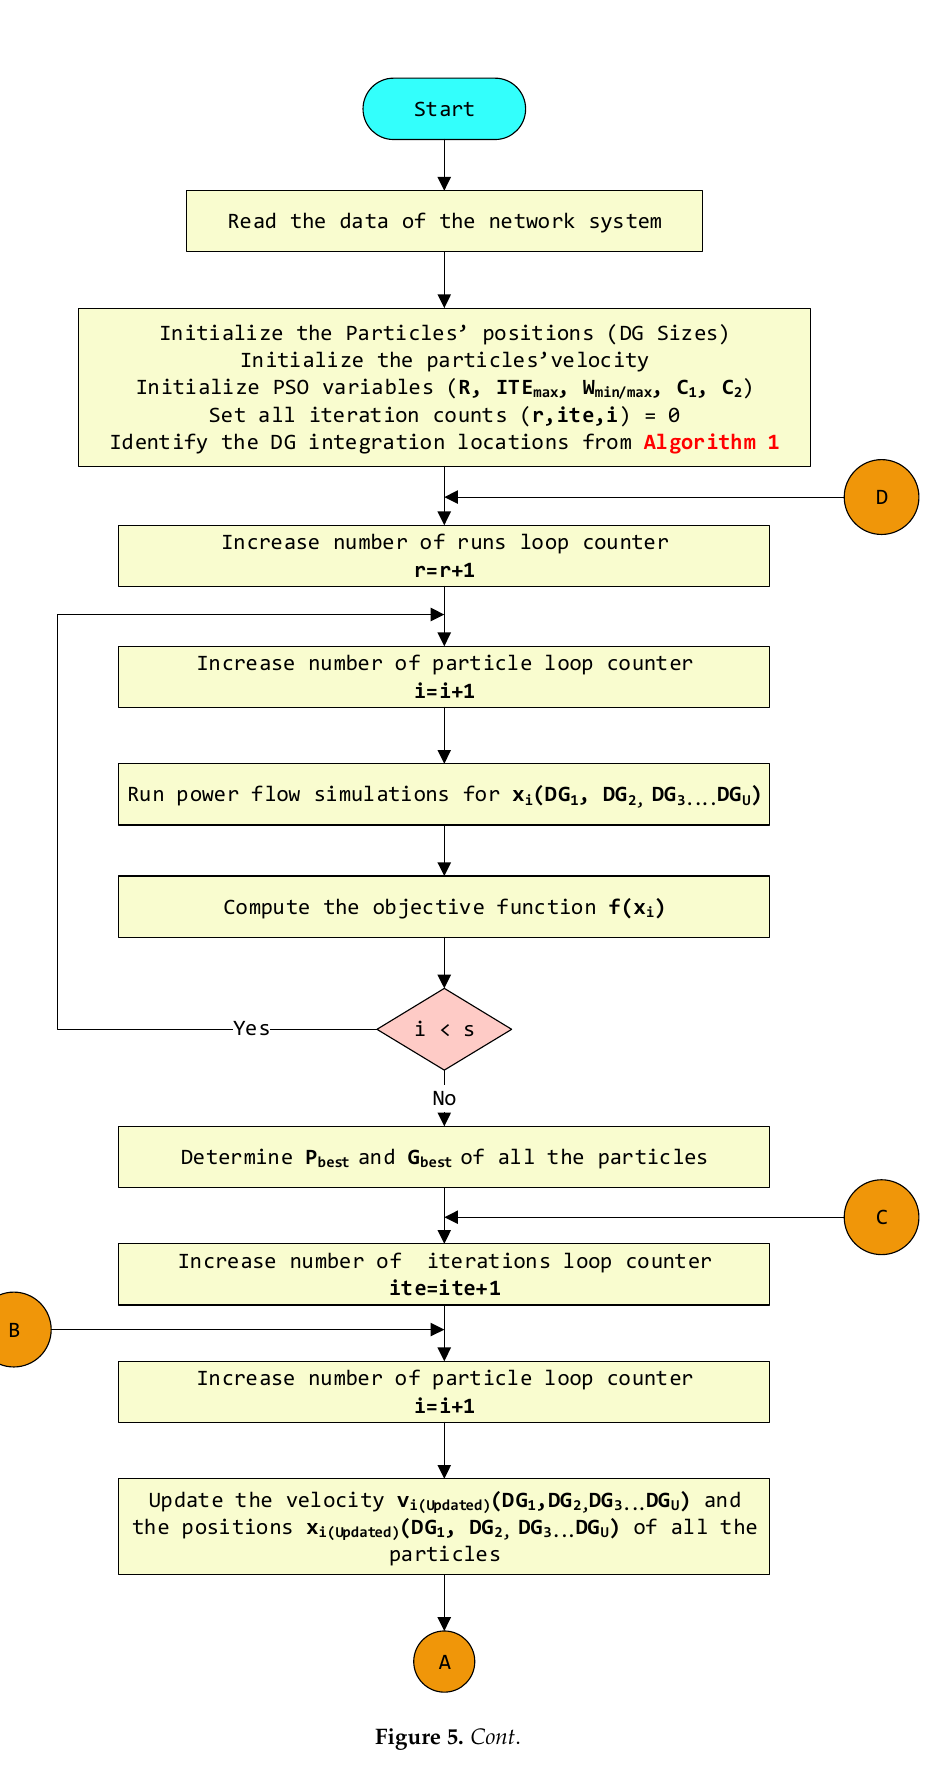
Figure 5. Flow chart of optimal sizing of DGs utilizing the particle swarm optimization (PSO) Figure 5. Cont algorithm—Algorithm 2.